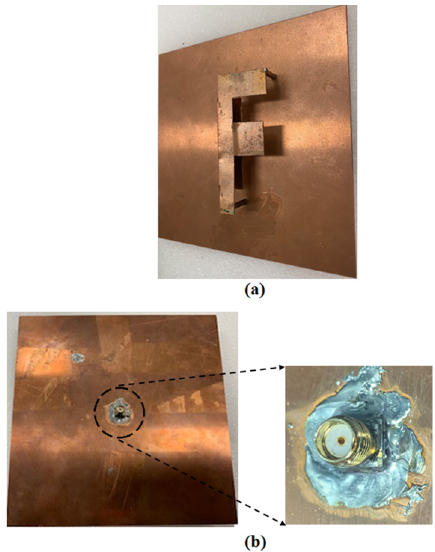
Figure 12. Fabricated prototype of the proposed patch antenna. ( a ) Top view and ( b ) bottom view.